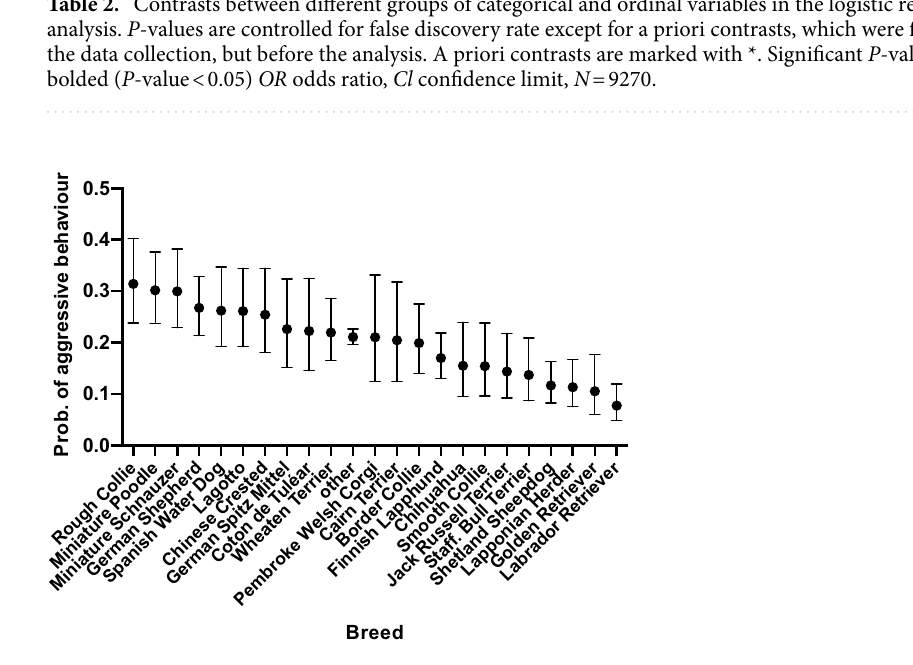
Figure 2. Probability of aggressive behaviour in 23 dog breeds or breed groups. Several breeds differed significantly from each other (Supplementary Table S2). Error bars indicate 95% confidence limits. N =